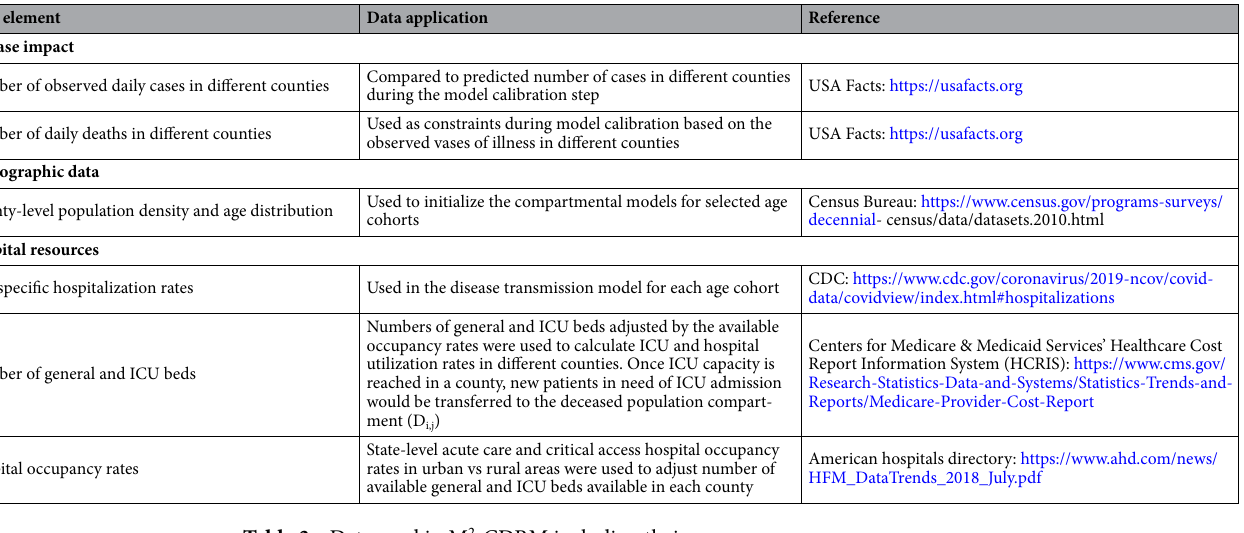
Table 3. Data used in M 2 -CDRM including their